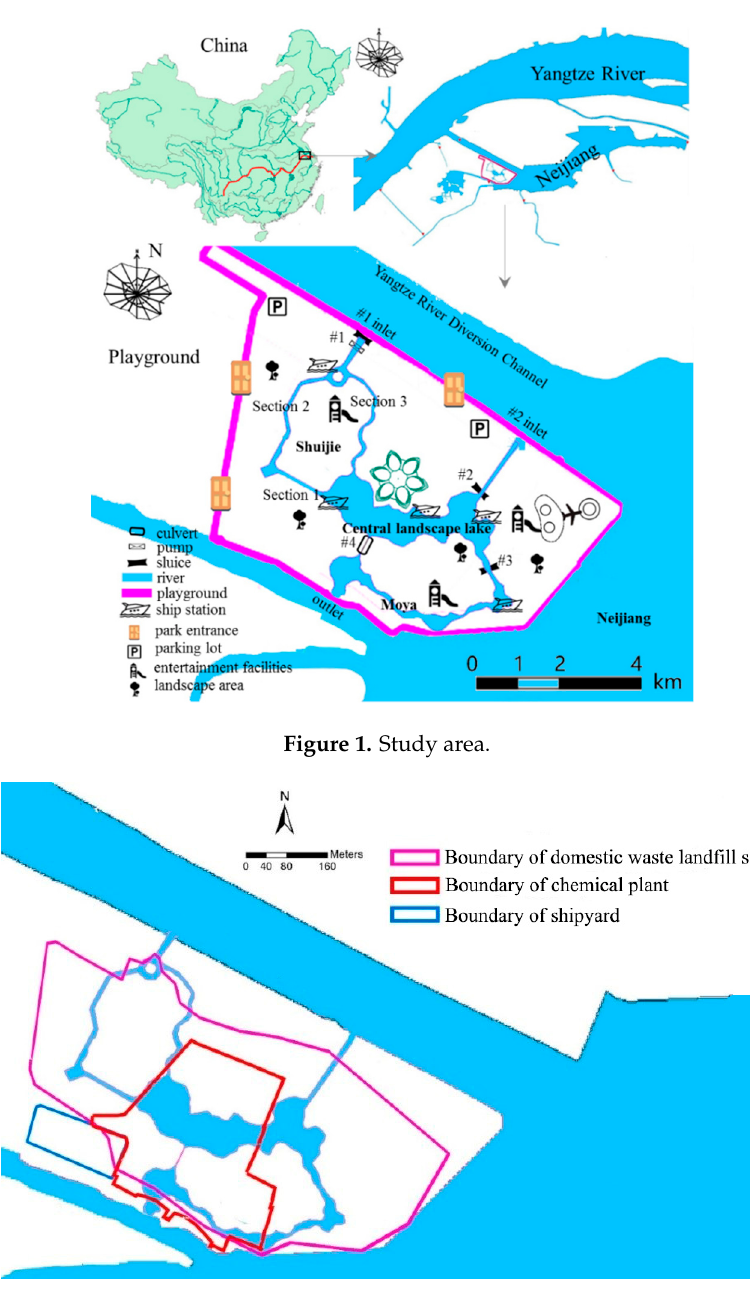
Figure 2. Chemical plant, domestic waste landfill site and shipyard area.